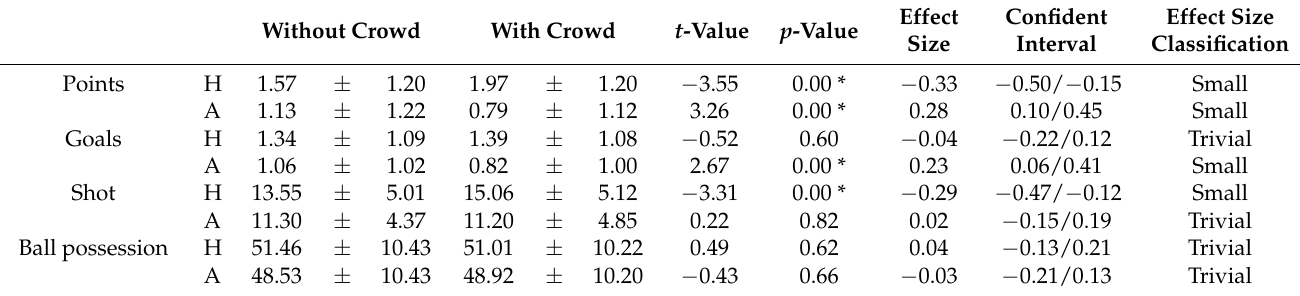
Table 2. Statistical and descriptive data across two seasons over the COVID-19 pandemic in the Brazilian Serie A